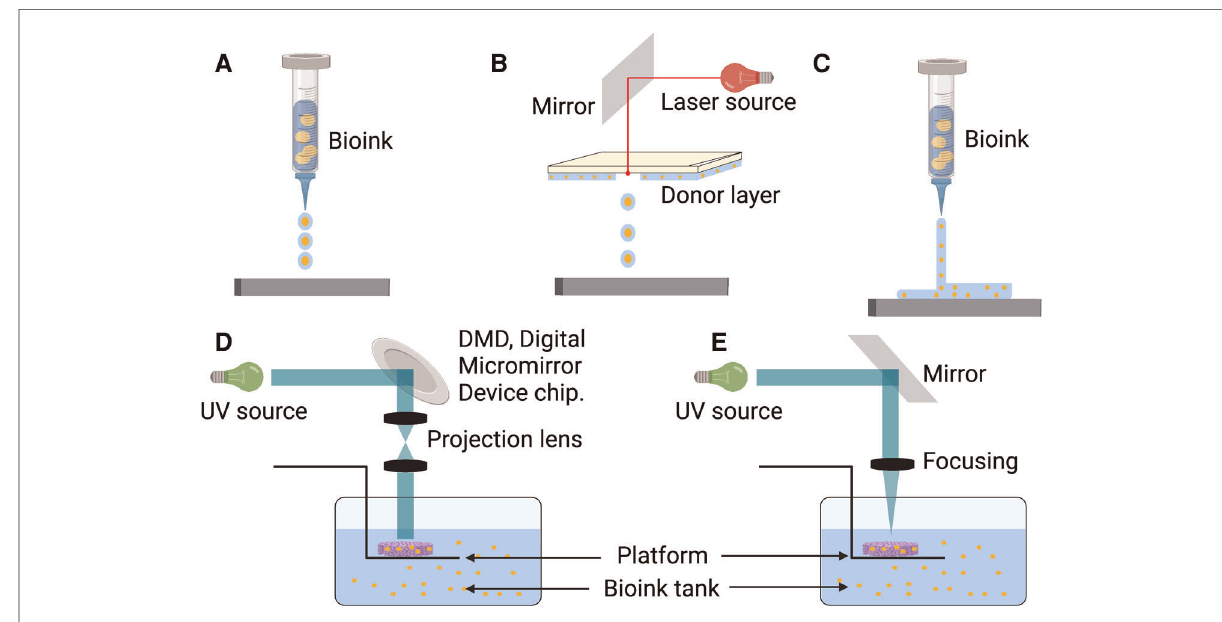
FIGURE 2 There are multiple strategies of 3D bioprinting, including inkjet bioprinting ( A ), laser bioprinting ( B ), extrusion-based bioprinting ( C ), SLA-based bioprinting ( D ), and DLP-based bioprinting ( E ). DLP, digital light processing; SLA,